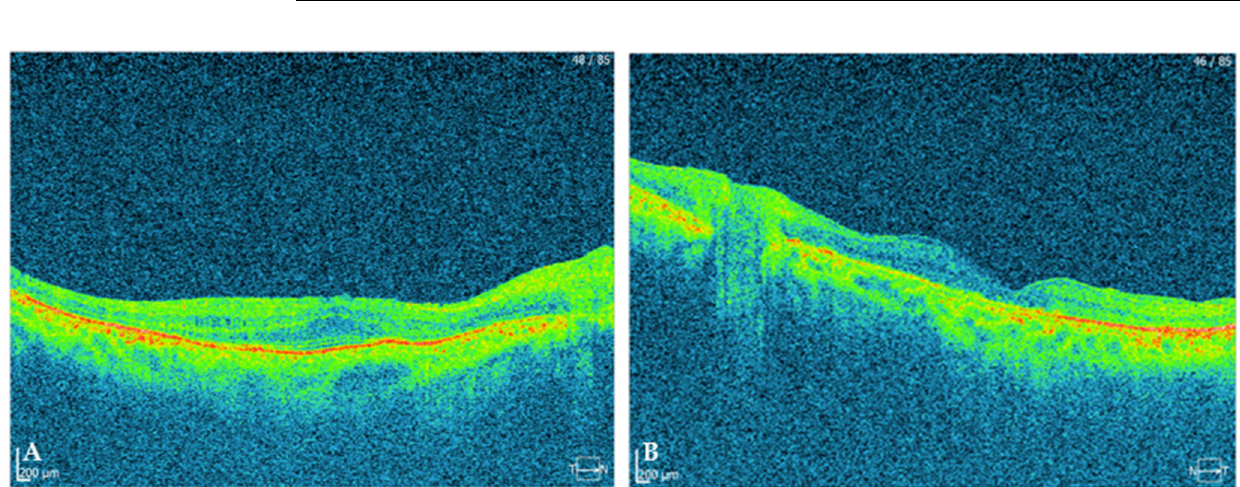
Figure 1. ( A ) SD-OCT image of the macula of the right eye; ( B ) SD-OCT image of the macula of the left eye.